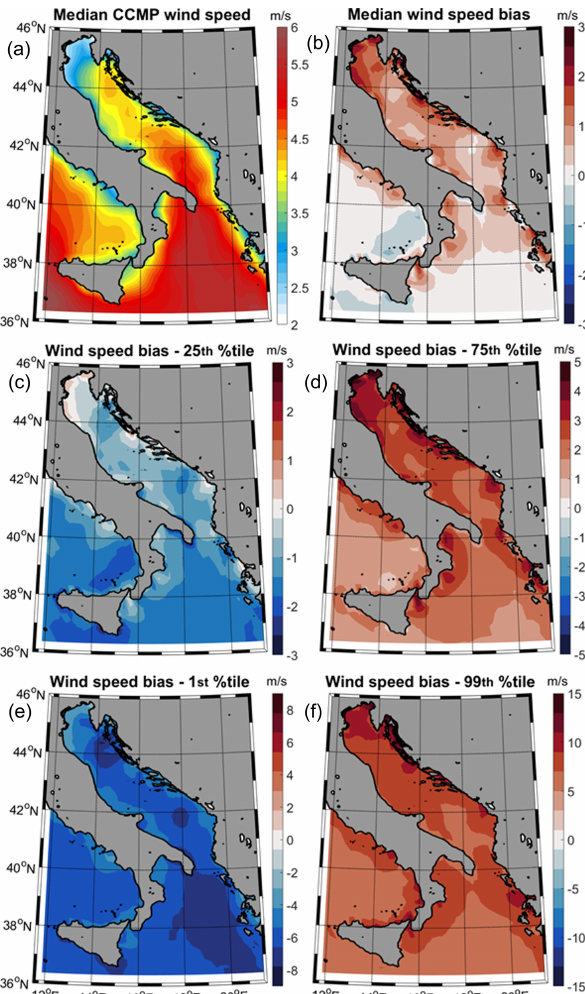
Figure 6. The same as in Fig. 3 but for the E-OBS daily mean pres- sure over the land. Figure 7. The same as in Fig. 3 but for the 6-hourly CCMP wind speed remote sensing data over the